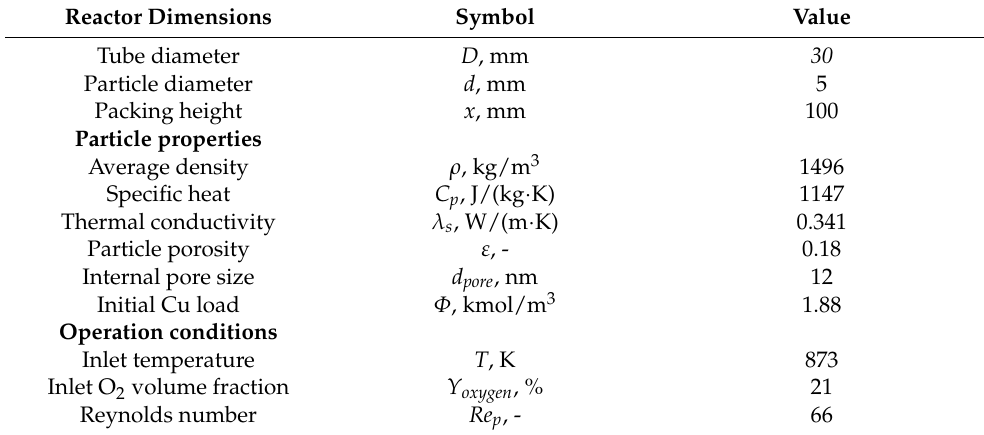
Table 5. The packed bed dimensions, particle properties and operating conditions of the simulation.